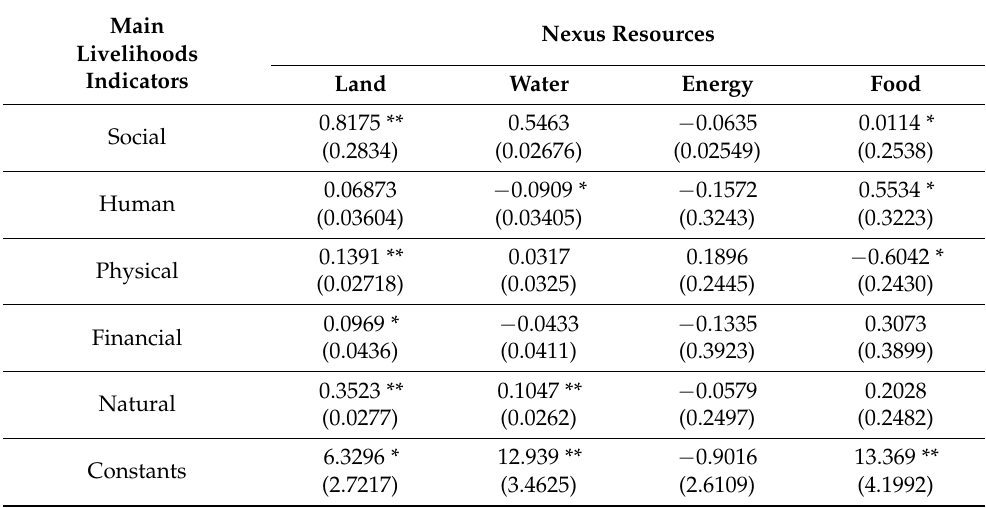
Table 7. Statistical analysis and testing of livelihood indicators with respect to LWEF